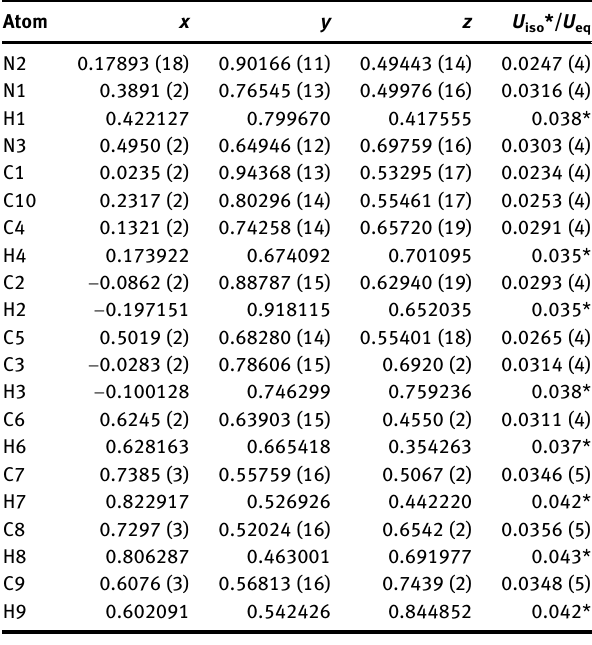
Table  : Fractional atomic coordinates and isotropic or equivalent isotropic displacement parameters (Å 